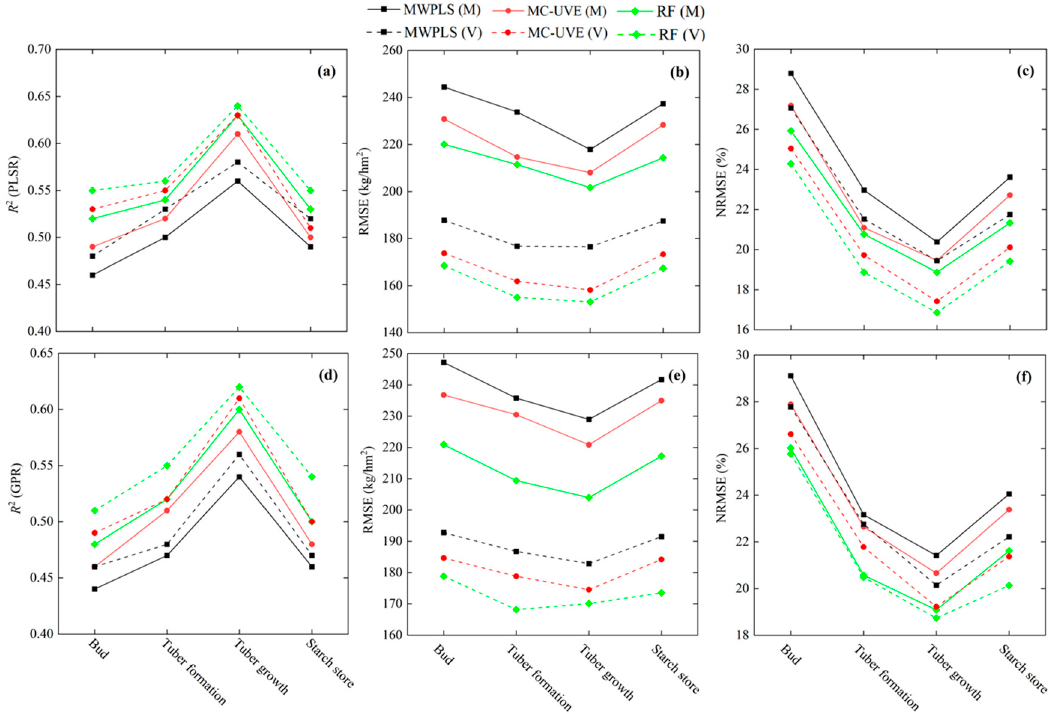
Figure 10. Accuracy of estimating AGB based on the feature variables screened from spectral-position parameters by MWPLS, MC-UVE and RF. ( a – c ) The R 2 , RMSE (kg/hm 2 ) and NRMSE (%) of AGB were estimated using the PLSR method. ( d – f ) The R 2 , RMSE (kg/hm 2 ) and NRMSE (%) of AGB were estimated using the GPR method.